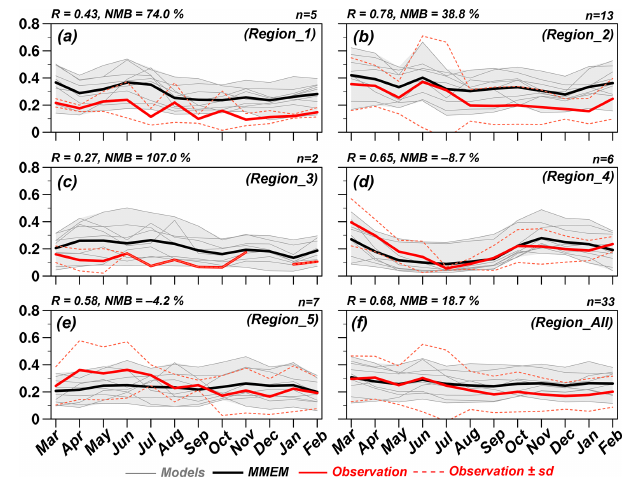
Figure 6. Similar to Fig. 4 but for seasonal cycles of AOD at 550nm. In this figure, the monthly measurements are taken from AERONET.